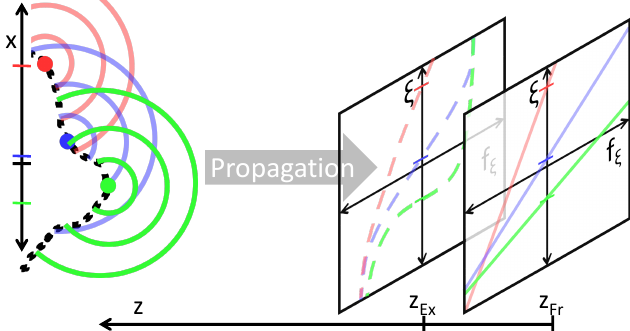
Figure 2. 1D hologram genesis starting from 3 specific points, and phase space footprint in the rigorous form at z Ex and within the Fresnel approximation at z Fr